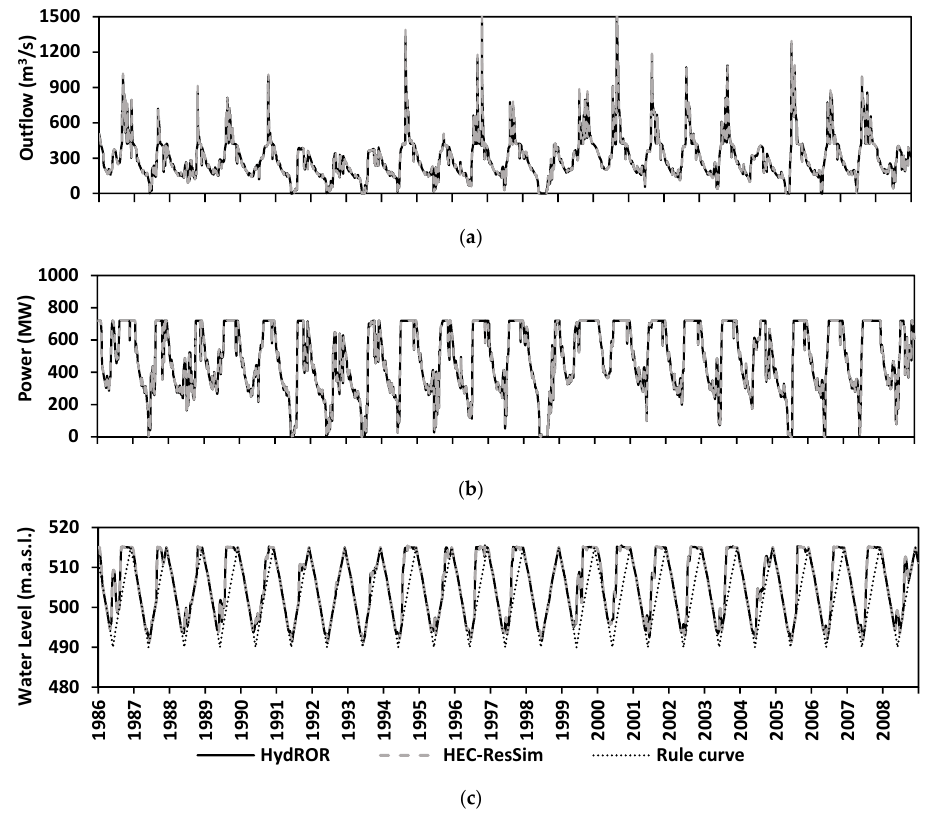
Figure 3. Comparison of ( a ) outflow from the reservoir, ( b ) power production and ( c ) reservoir water level of the Yali hydropower scheme, as determined using HydROR and HEC-ResSim.